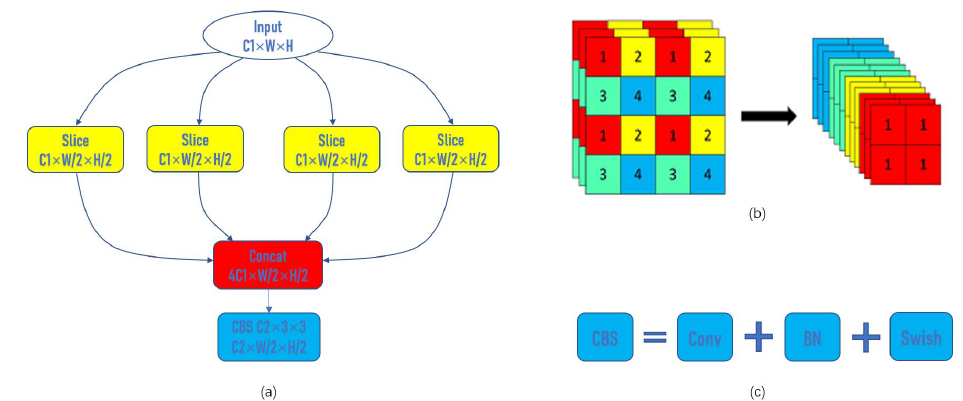
Figure 1. Structure of Focus-Block. ( a ) Specific operation process of Focus-Block. ( b ) Schematic diagram of Focus-Block. ( c ) Structure of CBS.